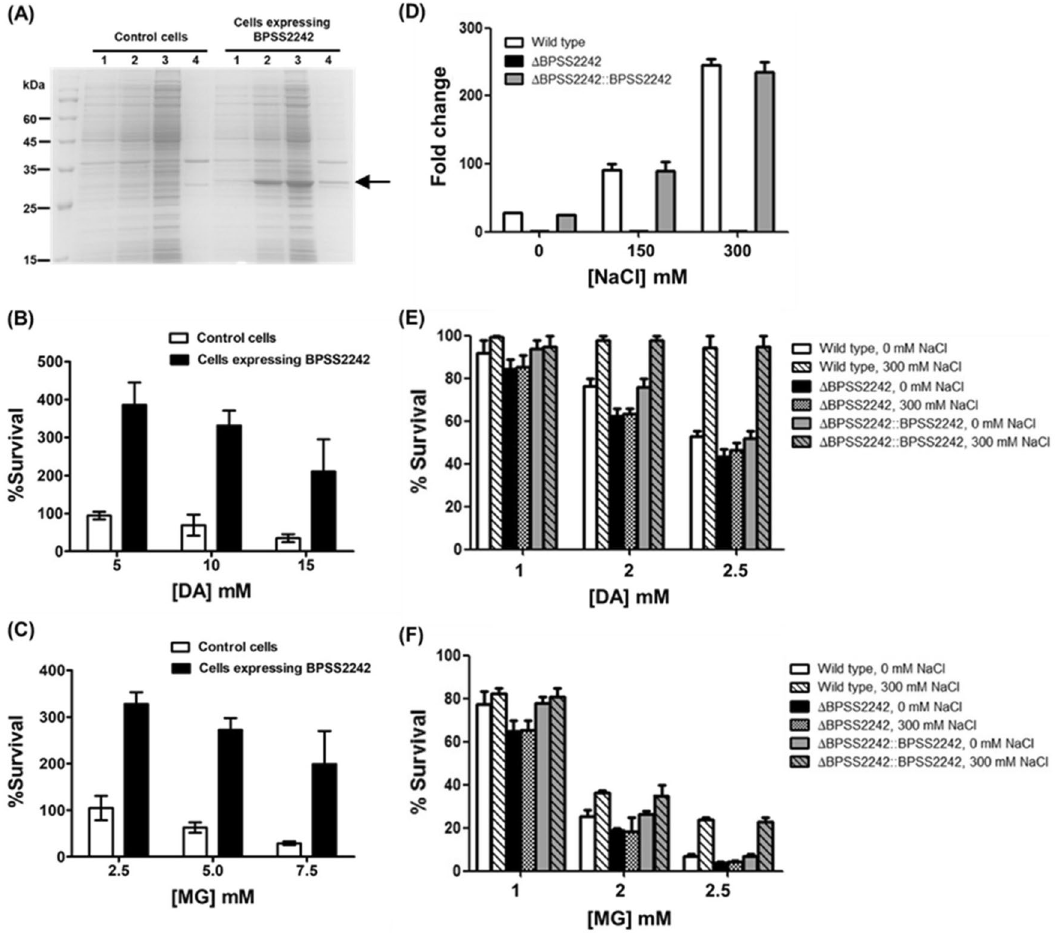
Figure 8. Survival of bacteria under dicarbonyl toxic stress. ( A ) Recombinant protein expression in BL21 (DE3). Lane 1, un-induced cells; lane 2, induced cells after 4 h induction with 1 mM IPTG; lane 3, soluble fraction; lane 4, insoluble fraction. Control cells are E. coli BL21 (DE3) carrying empty pET23a plasmid. Survival of E. coli was determined after exposure to ( B ) diacetyl and ( C ) methylglyoxal. ( D ) Confirmation of BPSS2242 transcript level of B. pseudomallei grown in LB medium containing 0, 150 mM and 300 mM NaCl by RT-PCR. The survivals of salt-treated and untreated B. pseudomallei WT, △ BPSS2242 mutant, and complemented strains after exposure to ( E ) diacetyl and ( F )